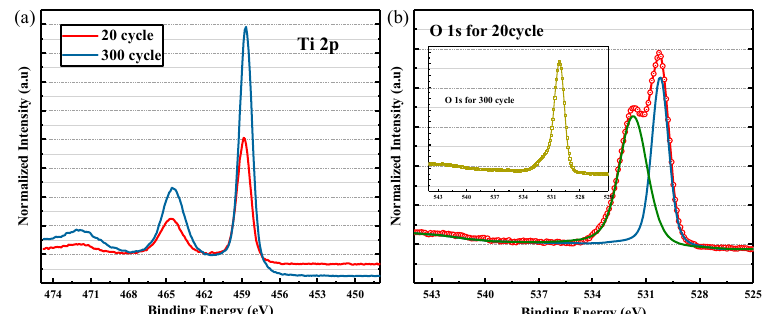
Figure 3. ( a ) The XPS results of Ti 2p of samples for 20 cycles and 300 cycles of ALD process. ( b ) The XPS results of O 1 s with thin TiO 2 , shoulder left to O 1 s peak is obvious. The illustration in the upper left corner shows the fitting curve of 300 cycles.